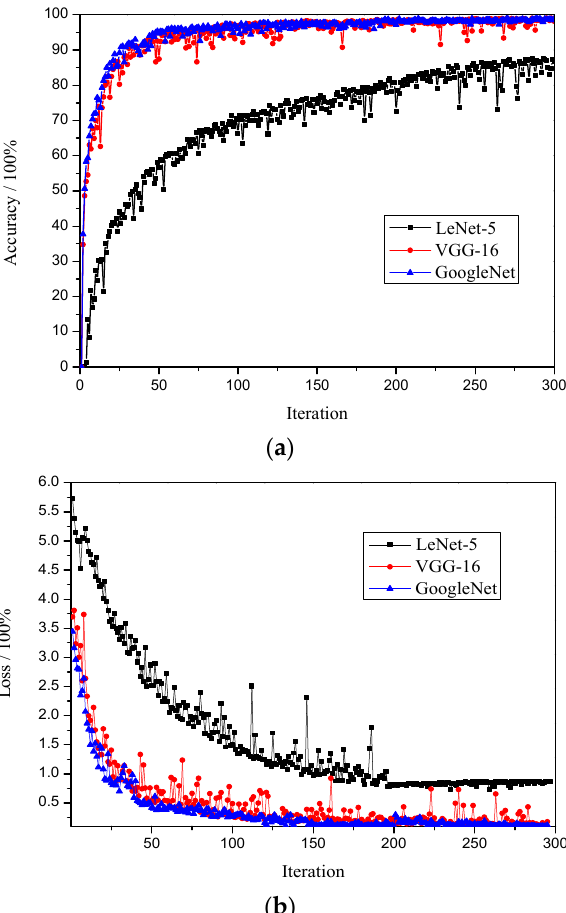
Figure 7. LeNet-5, VGG-16, and GoogleNet models. ( a ) Accuracy; ( b ) loss .